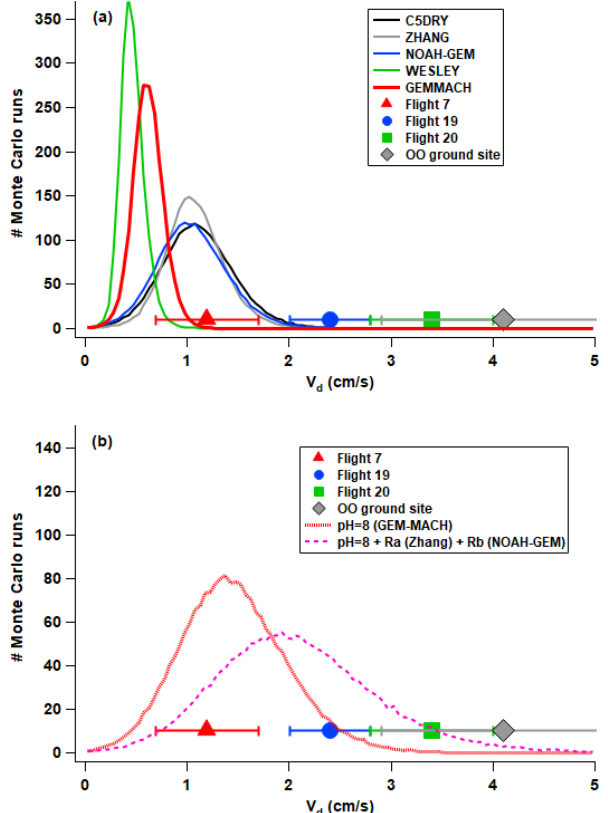
Figure 5. (a) Distributions of V d for SO 2 from Monte Carlo simu- lations using five different deposition parameterizations (Wu et al., 2018; Makar et al., 2018) and (b) Monte Carlo simulations for the GEM-MACH algorithm using a pH = 8 and using a pH = 8 plus re- placing the GEM-MACH algorithm R a and R b formulae with that from Zhang et al. (2002) and NOAH-GEM (Wu et al., 2018), re- spectively. Aircraft-derived V d for F7, F19 and F20 as well as the median value for the Oski-ôtin ground site (Supplement Fig. S5) are shown in both (a) and (b) for